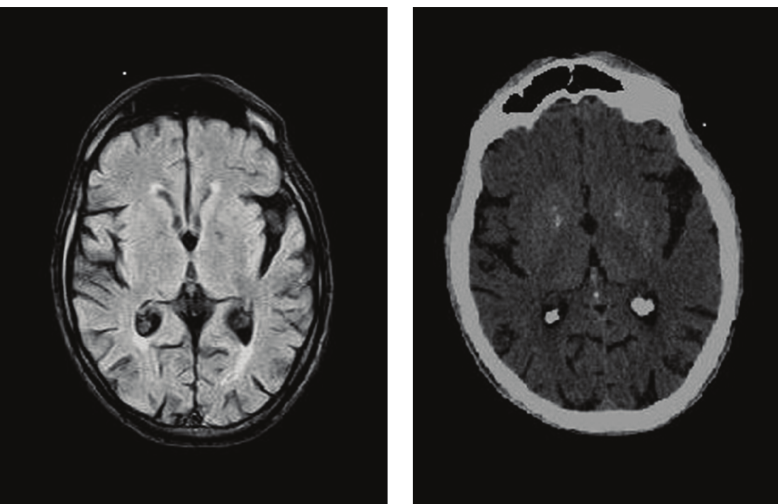
Figure 1: MRI scan on the left and CT scan on the right performed under pharmacological sedation in order to reduce motion artifacts, showing moderate diffuse cortical atrophy and small bilateral basal ganglia